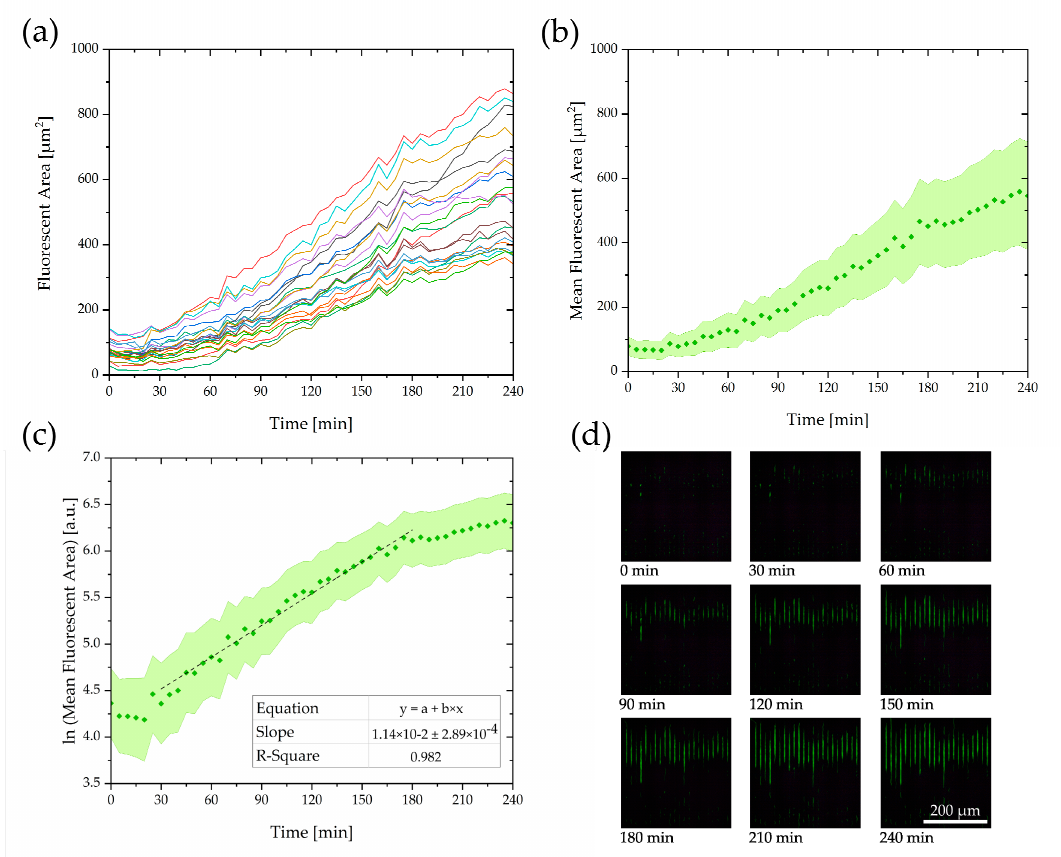
Figure 6. ( a ) Plot of the fluorescent area F of the individual channels over time. ( b ) Mean value M F of the fluorescent area over time. ( c ) Plot of the logarithm of the averaged area M F over time with the linear fit to determine the bacterial growth rate. ( d ) Fluorescence images taken during the growth experiments in intervals of 30 min for 4 h.